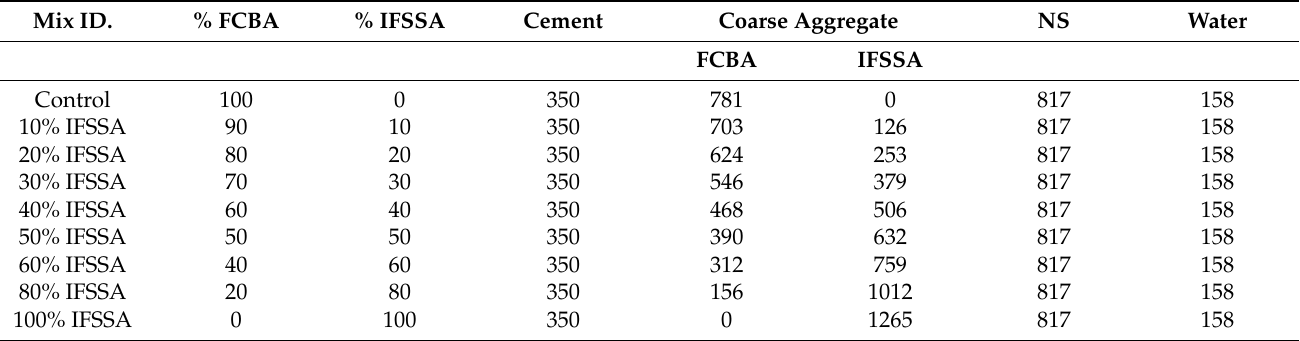
Table 2. Mix design of the concrete mixes (kg/m 3